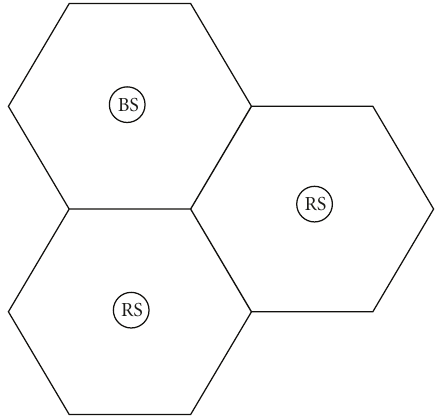
Figure 4: Evaluation scenario with three